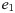
Expansion.(a) Expand e1 and e2 based on edge e. (b) The path after being expanded (triangles represent p-nodes, hollow circles represent d-nodes to be filled, and solid circles represent filled nodes).